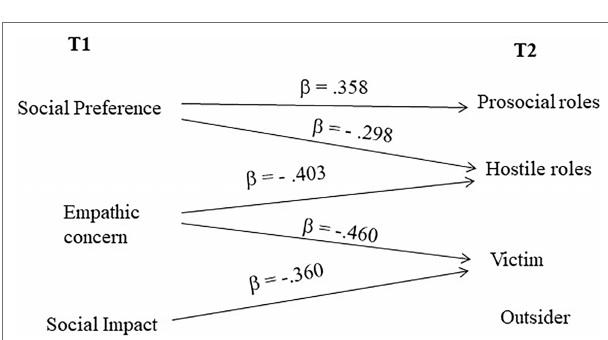
FIGURE 2 | Significant predictors at t1 of social status indices at t2 (regression